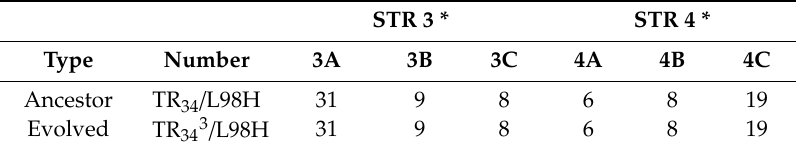
Table 1. Microsatellite locus genotyping.